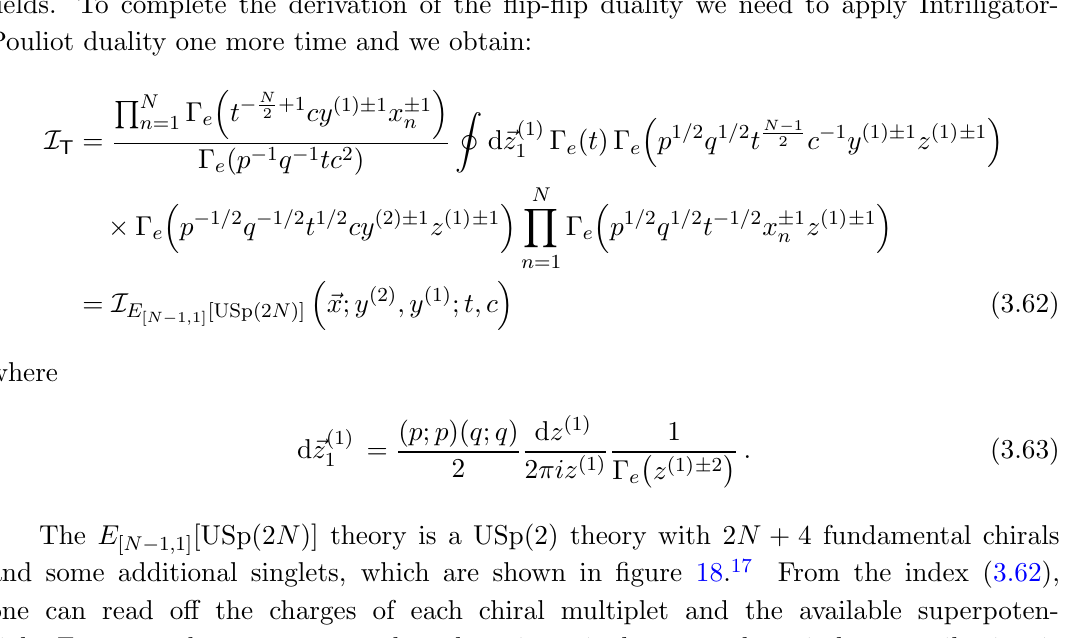
[USp(2 N [ N (cid:0) 1 ; 1]